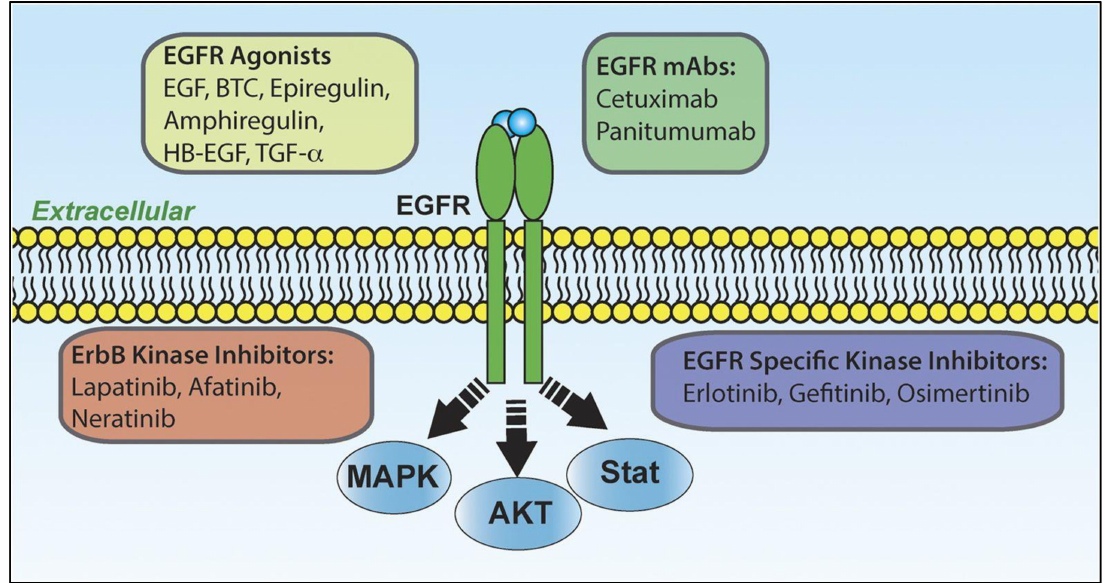
Figure 5. A schematic representation of the activators, inhibitors and outcomes of epidermal growth factor receptor (EGFR) signaling. EGFR is part of the four-member ErbB superfamily (ErbB1–4). These receptors form several di ff erent homo- and heterodimers (here we only depict the EGFR homodimer). EGFR is capable of binding several di ff erent extracellular ligands that agonize the receptor leading to activation of several downstream signaling events including, but no limited to those listed. Several therapeutics have been developed to antagonize EGFR including monoclonal antibodies (mAbs) that block ligand binding as well as several di ff erent kinase inhibitors. In addition to EGFR, some of these kinase inhibitors also target other ErbB receptors, supporting their use in human epidermal growth factor receptor-2 (Her2)-amplified breast cancer (BC). All of the listed therapies are Food and Drug Administration (FDA) approved for various cancers with the exception of Neratinib. Reproduced with permission from Ali R and Wendt MK. The paradoxical functions of EGFR during breast cancer progression. Signal Transduction and Targeted Therapy 2017, 2(16042), 1–7